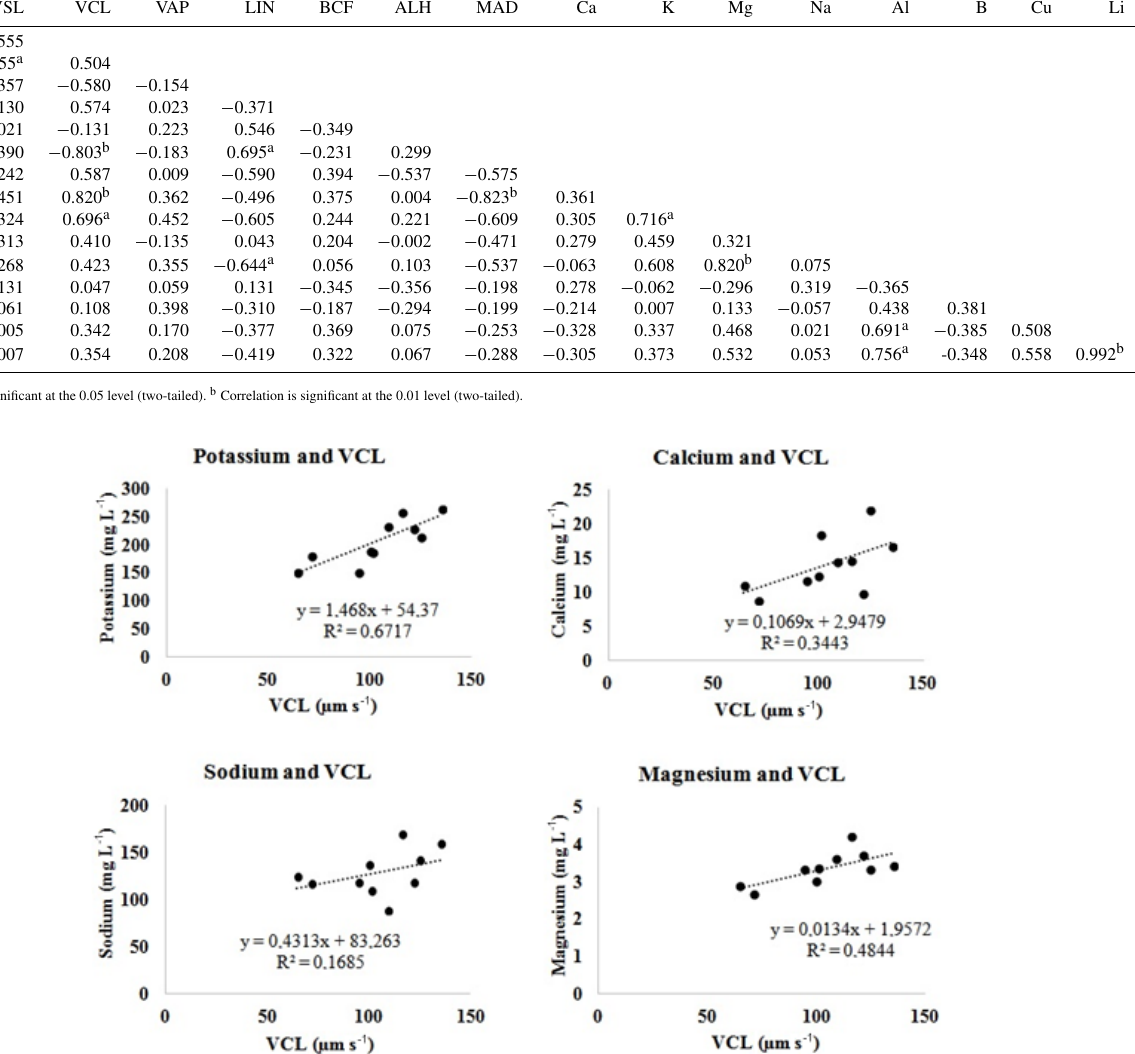
Pearson correlations